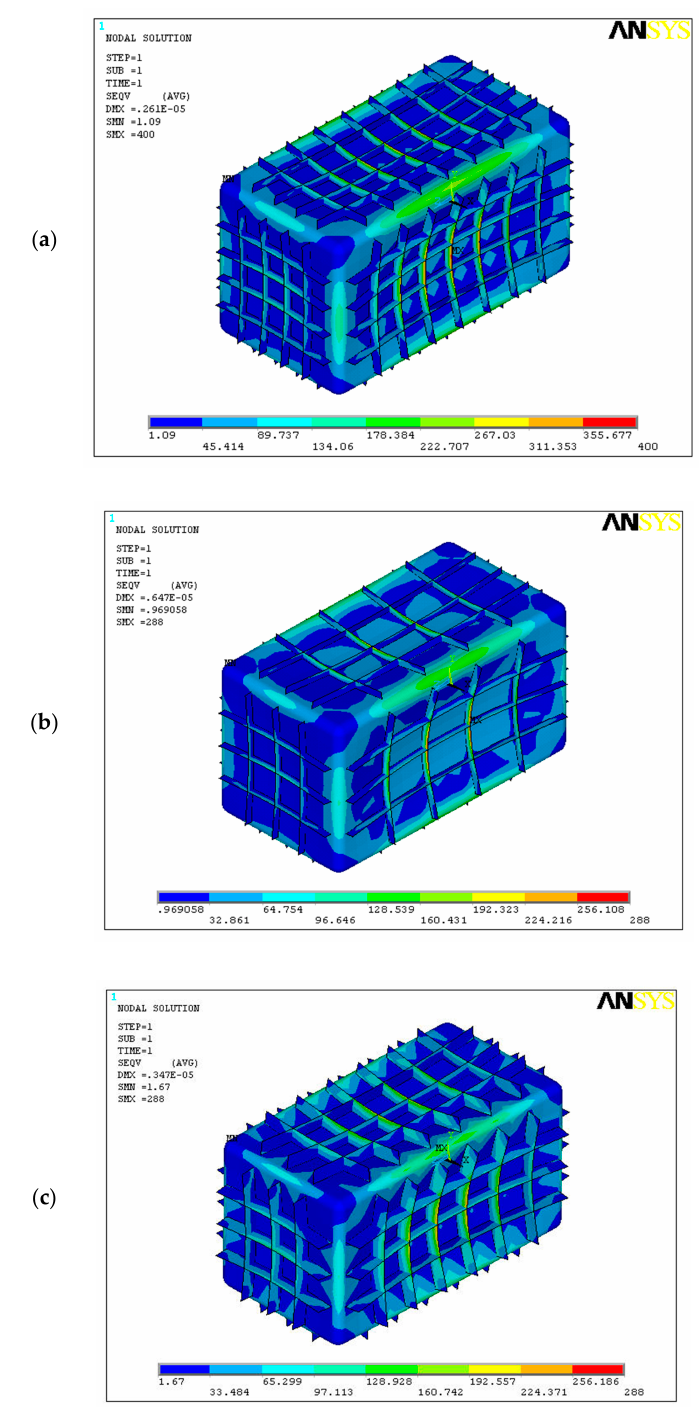
Figure 7. The results of stress analysis of the optimized compartments made of different materials including ( a ) steel compartment, ( b ) aluminum compartment (depth of 20 m), and ( c ) aluminum compartment (depth of 60 m).